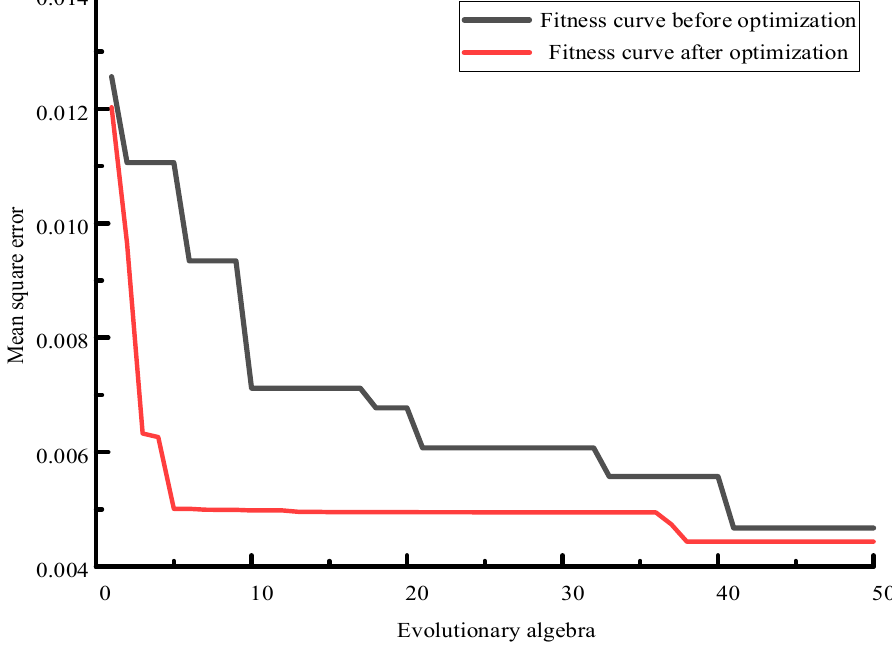
Figure 10. Convergence curve of the hybrid network